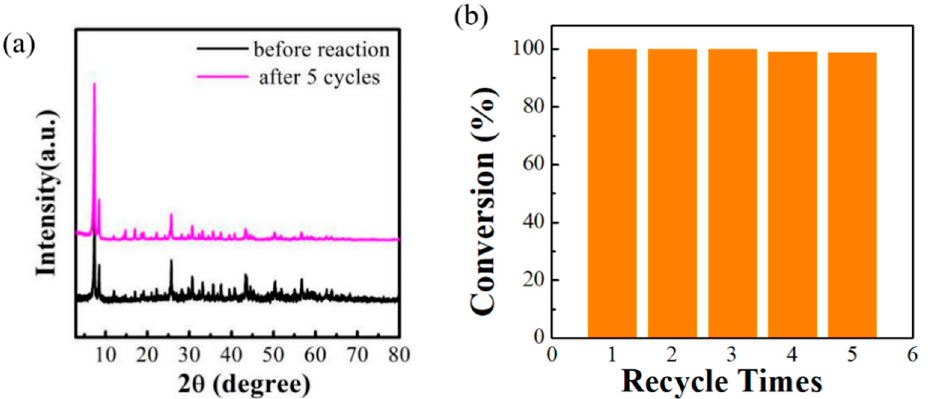
Figure 6. XRD patterns ( a ) and ODS activities ( b ) of the used TiF 4 -PU-200 after five cycles.